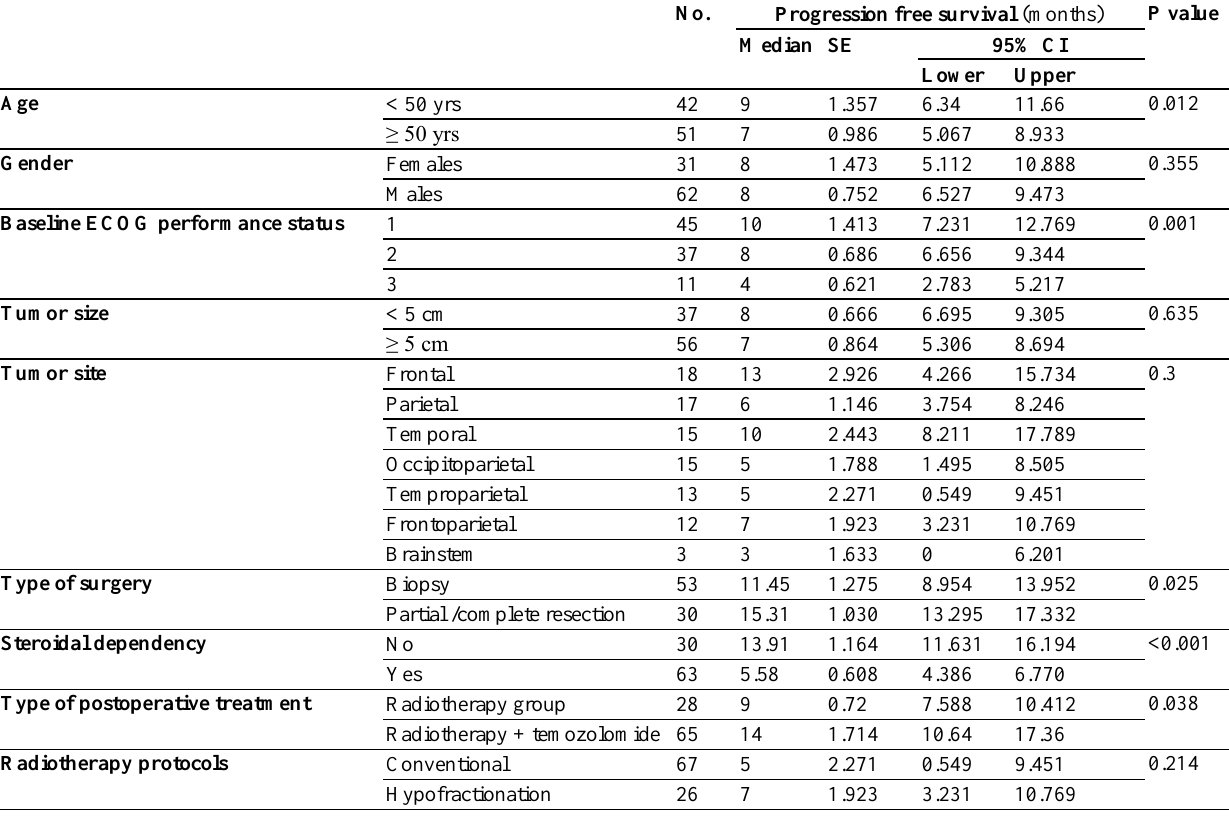
Table 2: Progression-free survival according to the studied